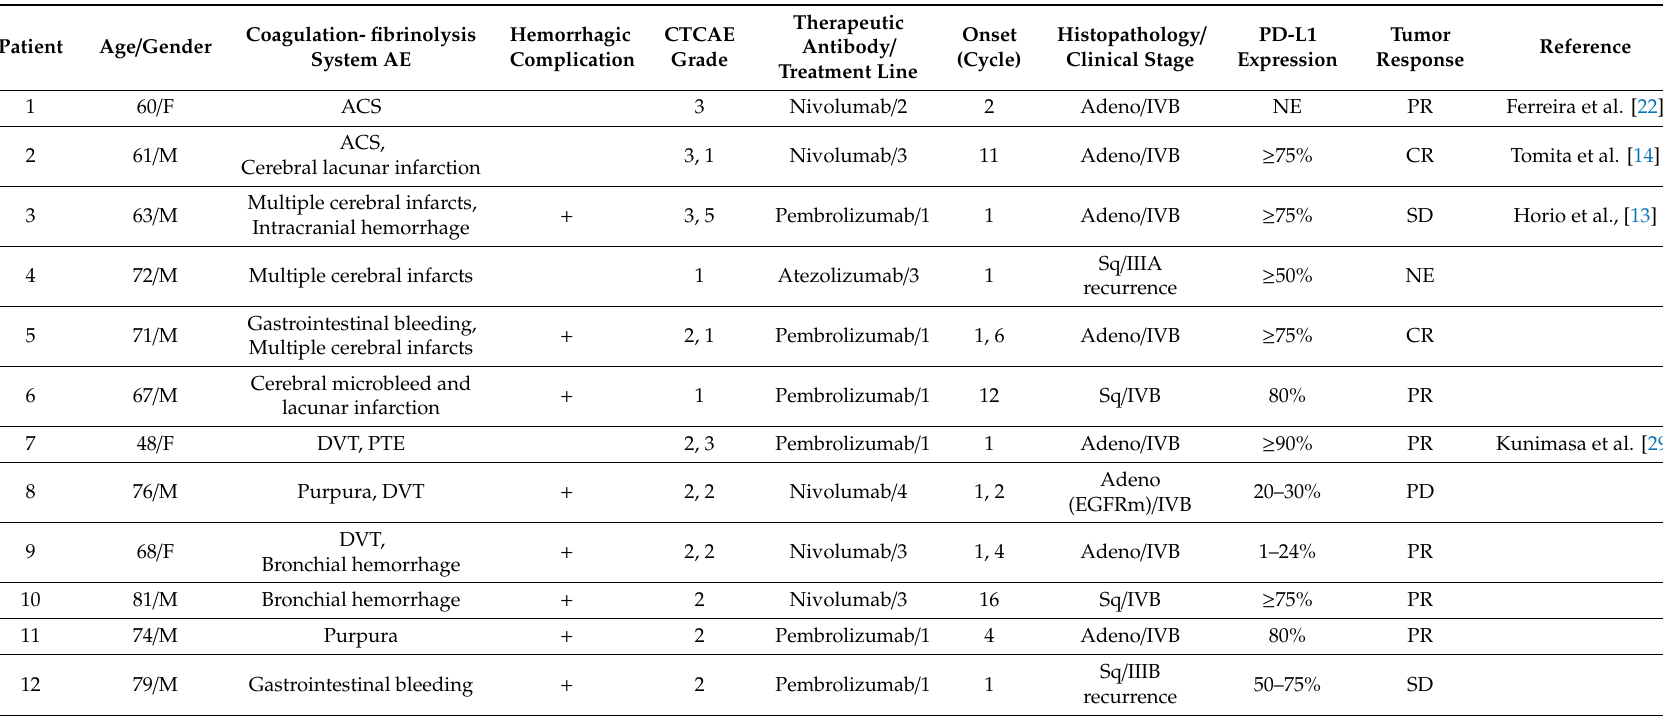
Table 1. Clinical features of NSCLC patients who developed diseases associated with disorders of coagulation-fibrinolysis system during immune checkpoint blockade